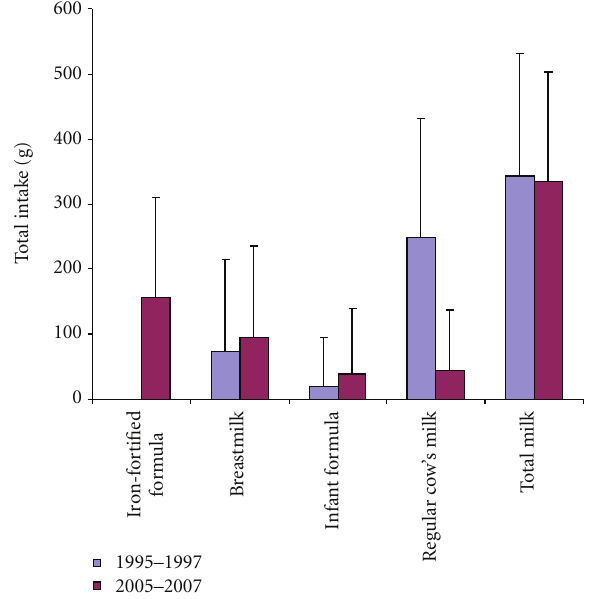
Figure 2: Di ff erence in milk consumption between previous, (1995–1997) and present (2005–2007) studies, showed as mean and